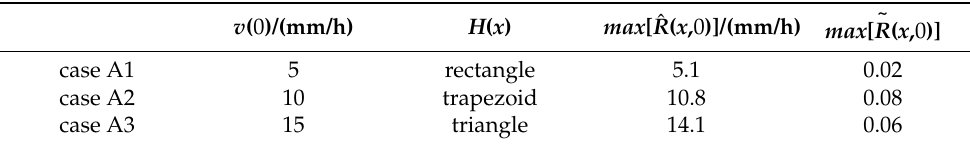
( c ) Figure A1. Retrieval effect of Equation (14). ( a ) Surface rain distribution on rectangular rain; ( b ) surface rain distribution on trapezoidal rain; and ( c ) surface rain distribution on triangular rain. Appendix B This appendix is the retrieval method of some precipitation parameters that are not described in detail in the text. According to the analysis in Section 2, the NRCS value at 𝑥 (cid:3039) starts to decrease signif- icantly due to the attenuation of the microwave by the bidirectional path. The value of 𝑥 (cid:3039) can be obtained by taking a continuous average of the values of n NRCS sample values. When the radar resolution is 250 m, n is taken as 5. Calculate the mean and standard de- viation of these 5 NRCS. If the sixth NRCS value is less than the mean of the previous 5